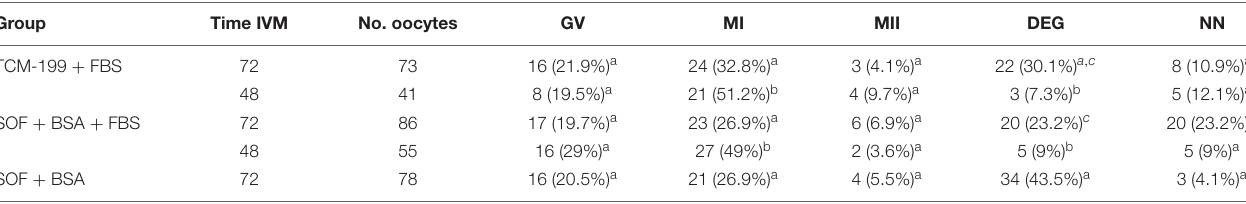
TABLE 3 | The effect of ITS supplementation on canine IVM for 72 h under high O 2 atmosphere. Group No. oocytes GV MI MII DEG NN SOF + BSA + FBS 71 SOF + BSA + FBS + 1 µ l/ml ITS SOF + BSA + FBS + 10 µ l/ml ITS